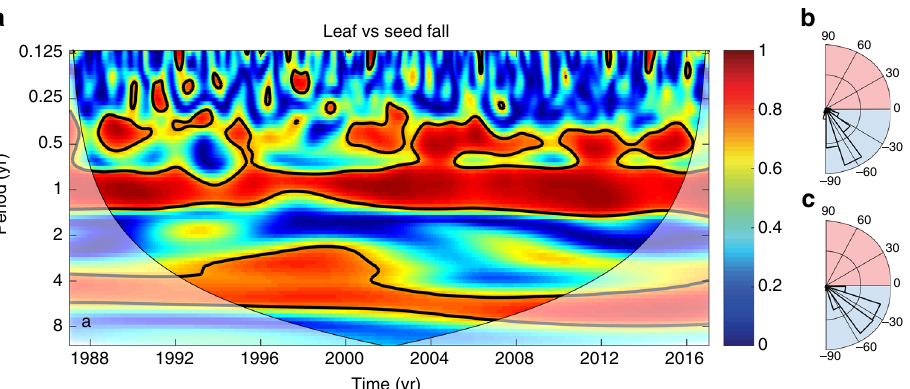
Fig. 6 Coordination between lea fi ng and fruiting at multiple temporal scales. a Wavelet coherence between leaf fall and seed fall shows strong coordination at both seasonal and ENSO cycles. b Phase-angle histogram for leaf fall and seed fall for the seasonal cycle and c for periods of 2 – 7 years, corresponding to the ENSO cycle. Phase angles were calculated for areas inside the cone of in fl uence and for coherence >0.5 in a . Negative angles (blue area) indicate that leaf fall leads seed